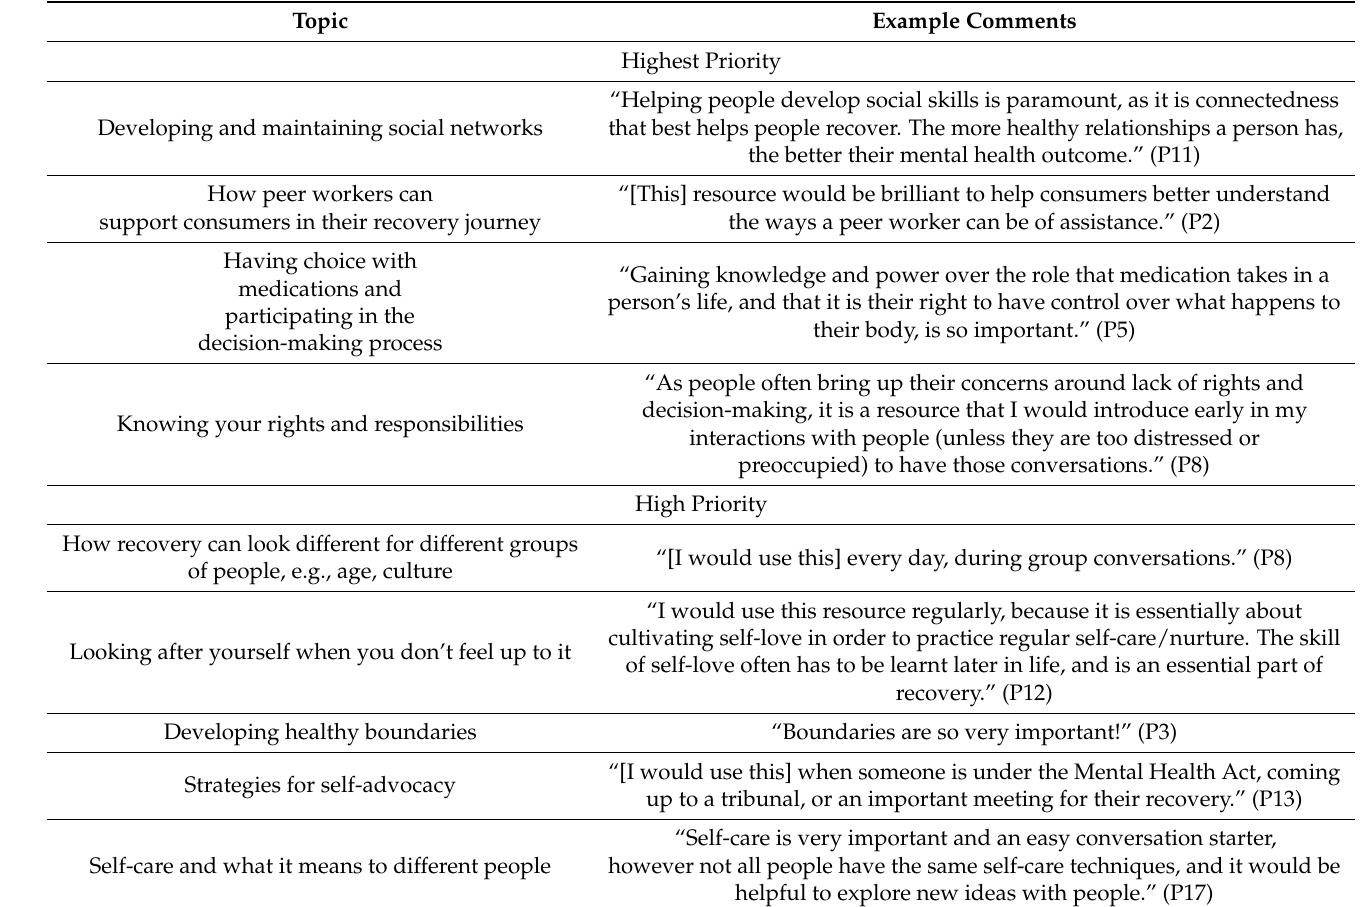
Table 3. Participants’ top priority topics for peer work with example